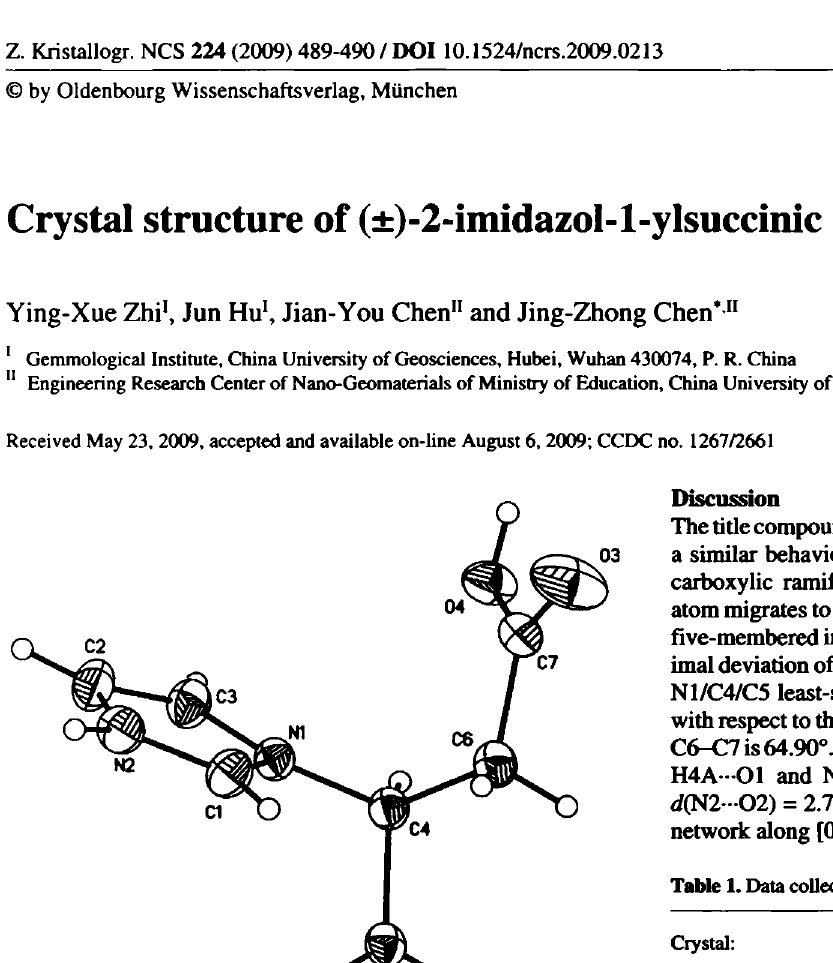
Table 1. Data collection and handling.